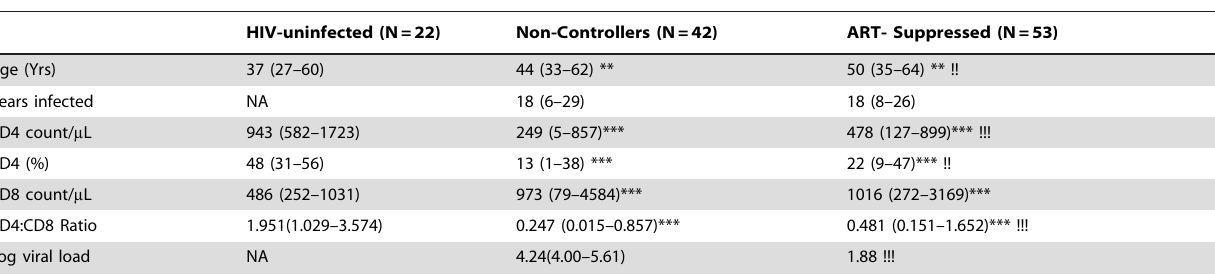
Table 1. Baseline Characteristics of